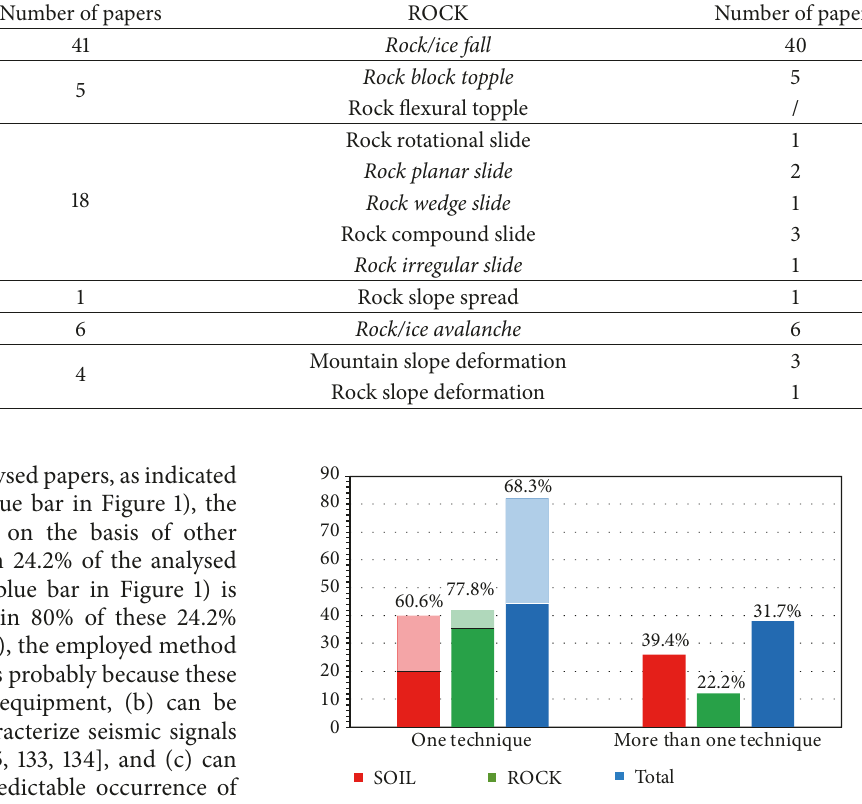
Figure 1: For each landslide typology (“soil” in red, “rock” in green, and total in blue), the bar graph shows the number of papers focused on just one technique or on more than one. Numbers on the top of the bars are the percentage values with respect to the total number of analysed papers. The darker colours of the “soil” and “rock” bars of the “one-technique” group indicate in how many works the passive seismic technique was employed alone. The dark blue portion of the “one-technique total bar” indicates in how many works other nongeophysical techniques were